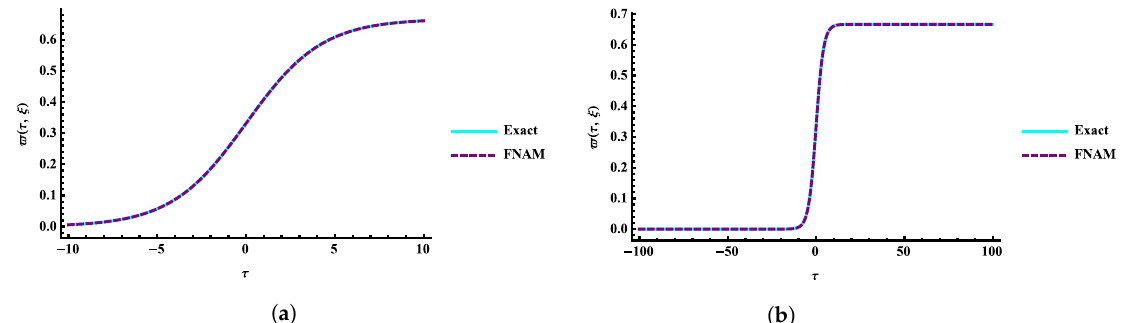
Figure 1. Comparison between the exact and numerical solutions by using FNAM verses ( a ) τ ∈